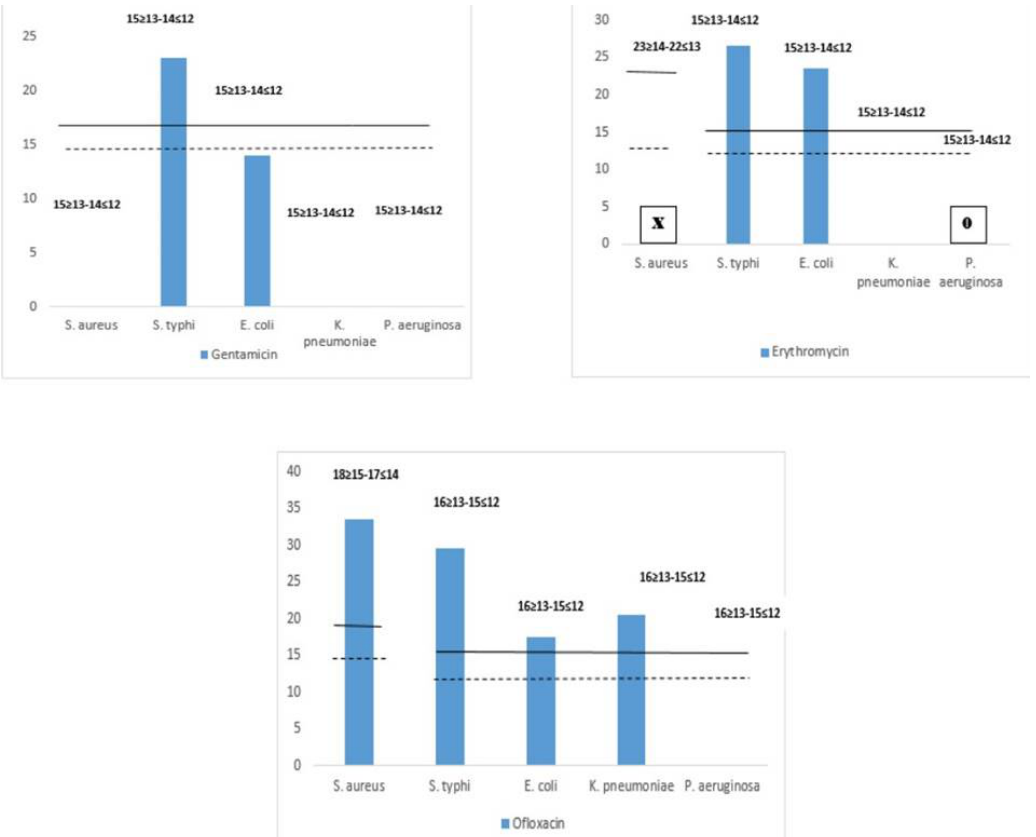
Fig. 5. Antimicrobial activity of some selected antibiotic disc on the tested